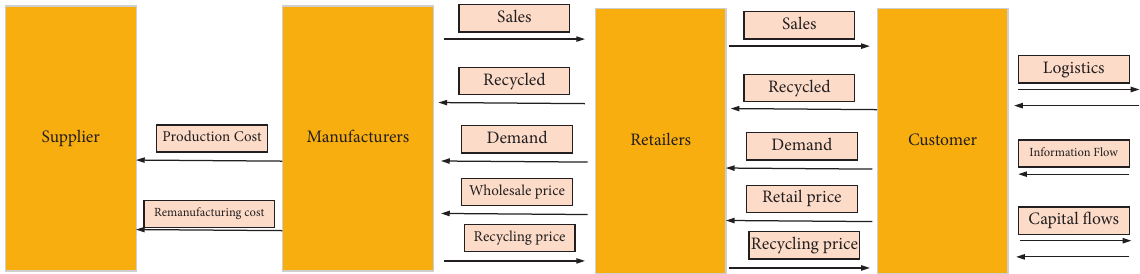
Figure 9: Two-stage closed-loop supply structure